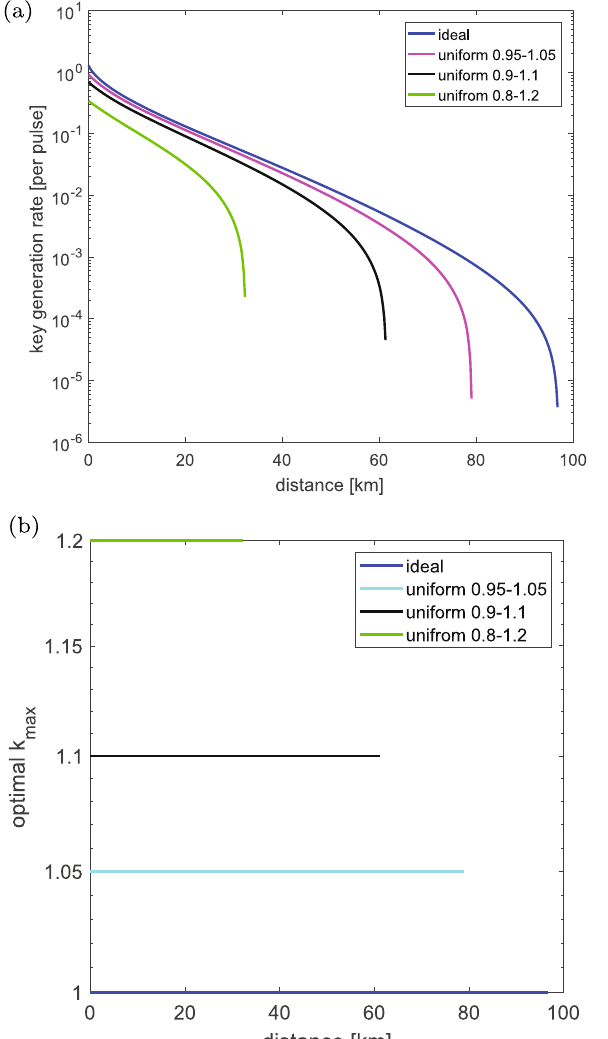
Fig. 7 Optimization for case (2B) with uniform distribution. ( a ) Secret key rate vs transmission distance. ( b ) Optimal k max versus transmission distance. Here, we optimize the secret key rate R R uniform distribution. a Optimal secret key rate versus transmission distance for different uniform distributions. b Optimal k max versus transmission distance for different uniform distributions.